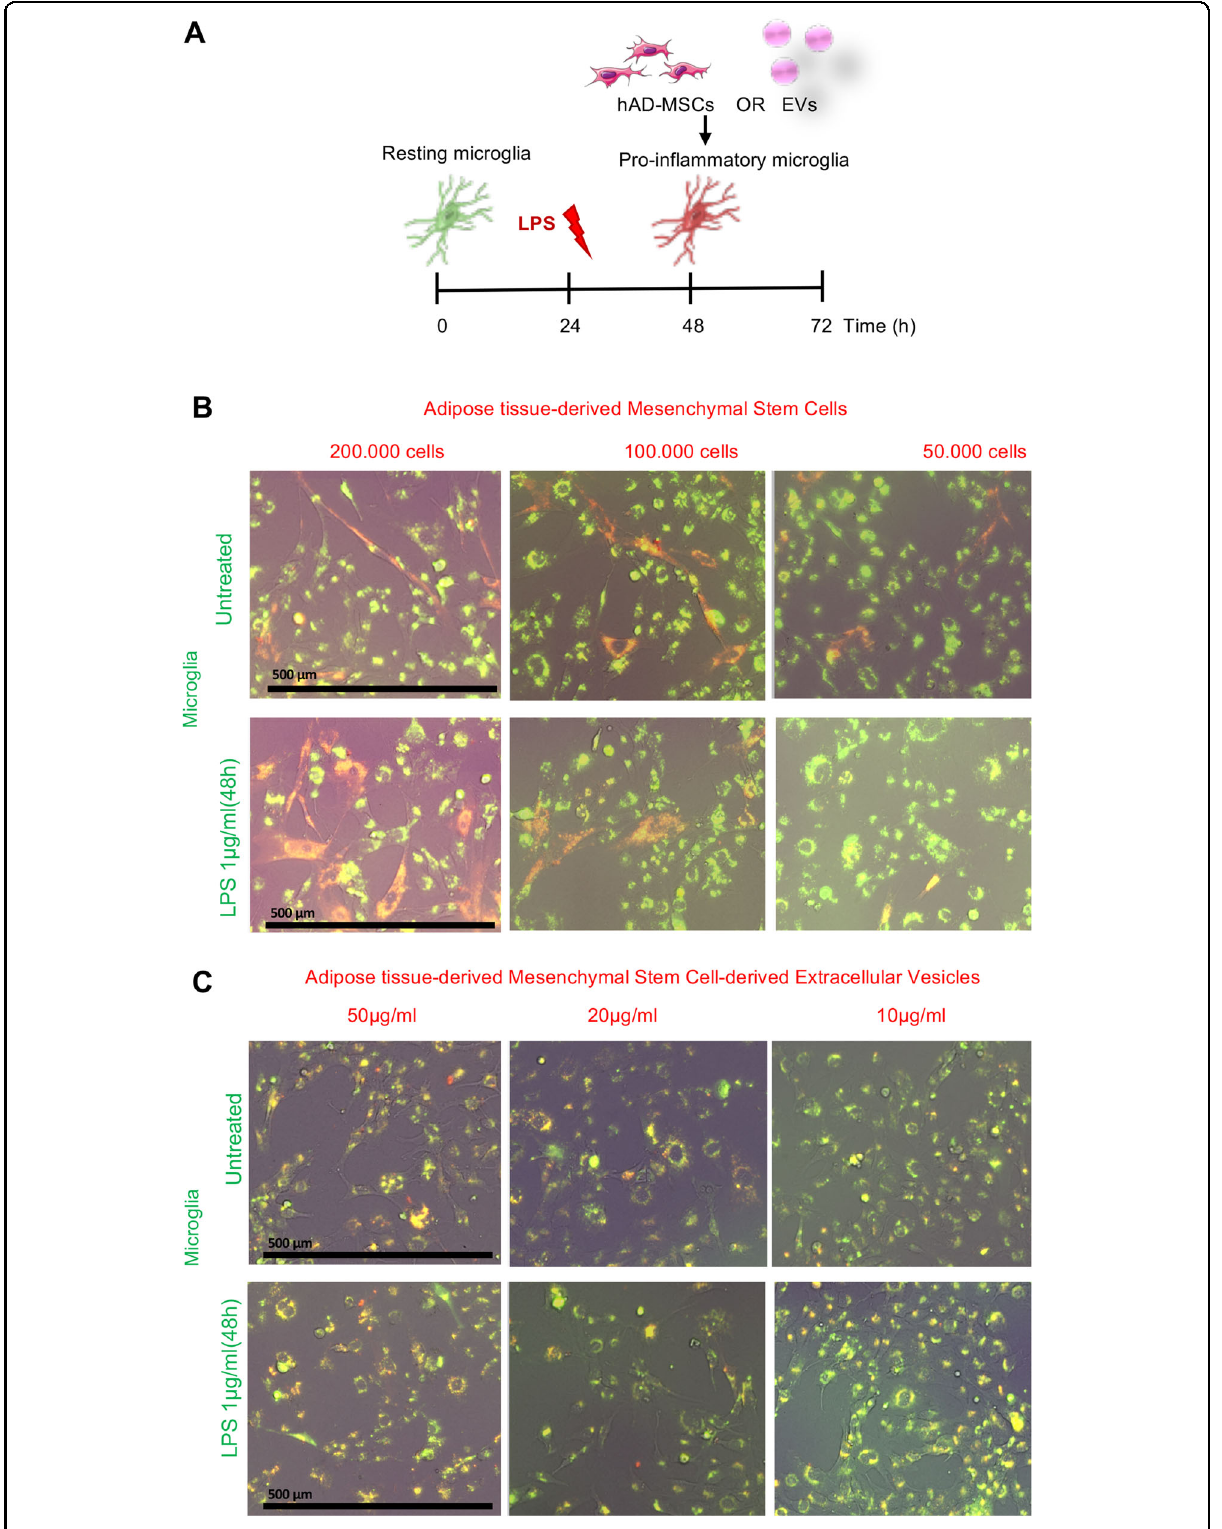
Fig. 3 Coculture of human HMC3 microglia cells and human adipose tissue-derived mesenchymal stem cells OR extracellular vesicles. A Schematic overview of the coculture protocol. B Fluorescence images of culture HMC3 microglia cells (green) and human adipose tissue-derived mesenchymal stem cells (red) in the presence or absence of 1 µg/ml LPS. C Fluorescence images of culture HMC3 microglia cells (green) and human adipose tissue-derived mesenchymal stem cell extracellular vesicles (red) in the presence or absence of 1 µg/ml LPS. Scale bar 500